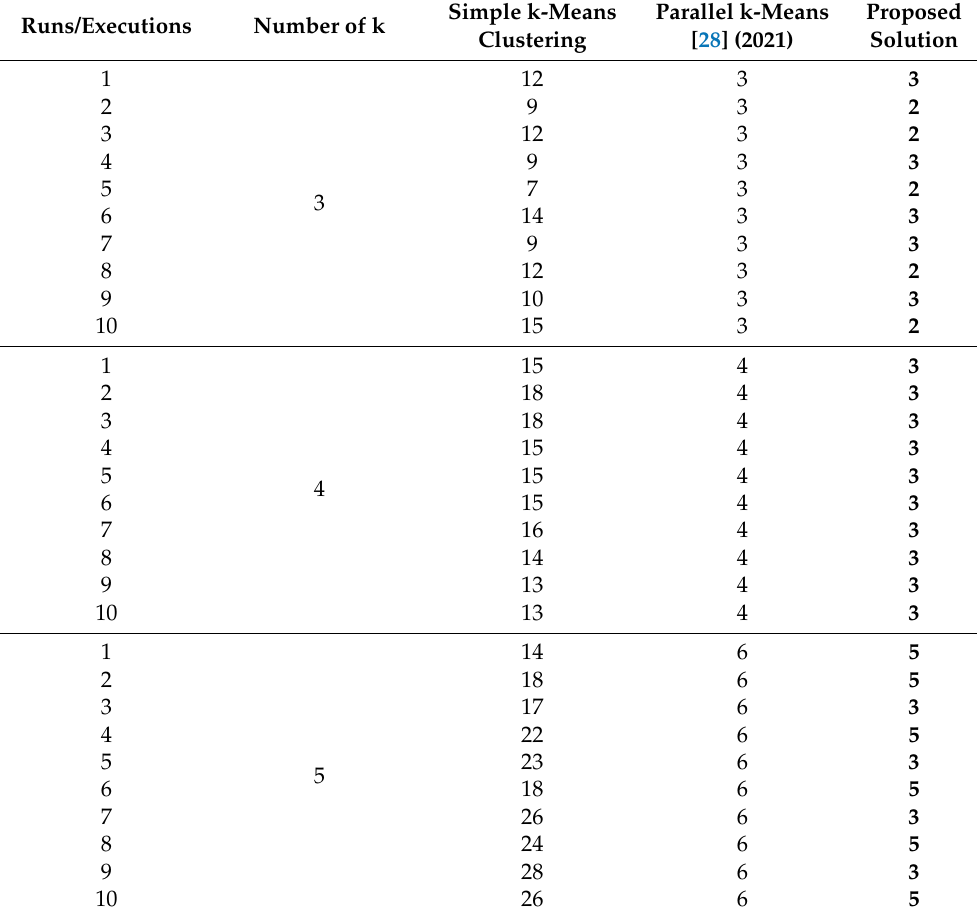
Table 5. Number of iterations for k